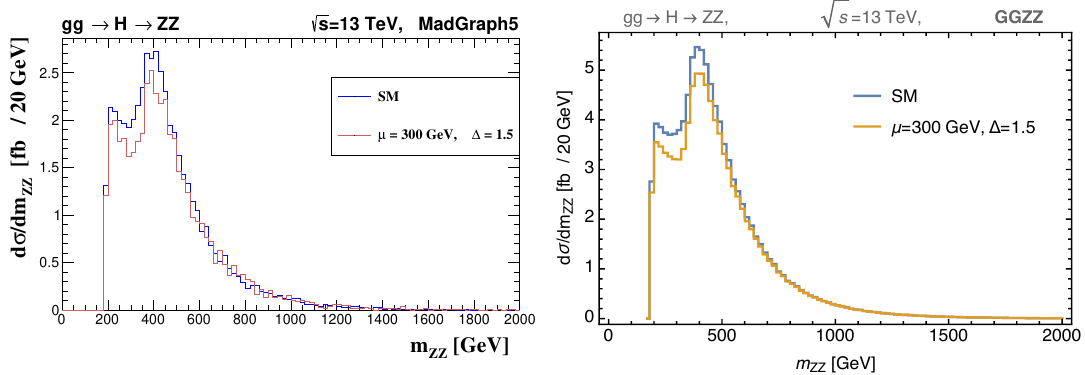
Figure 11. gg ! H ! ZZ versus the invariant mass of the two Z bosons and with the Z bosons